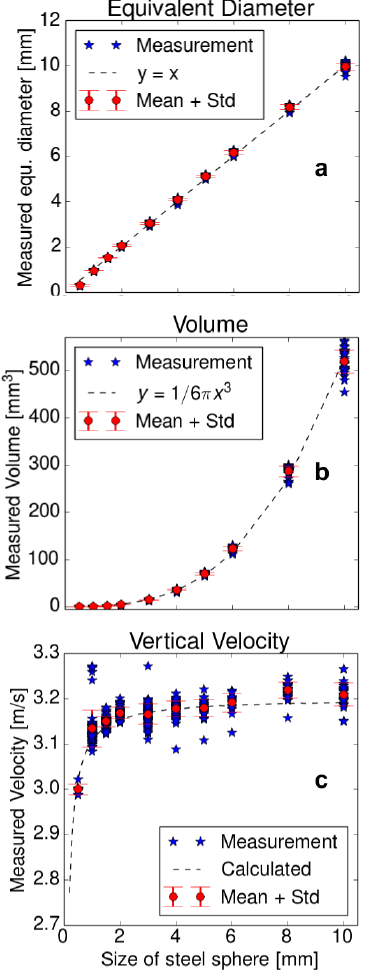
Figure 11. Comparison between measured and expected values for equivalent diameter (a) , volume (b) and vertical velocity (c) .